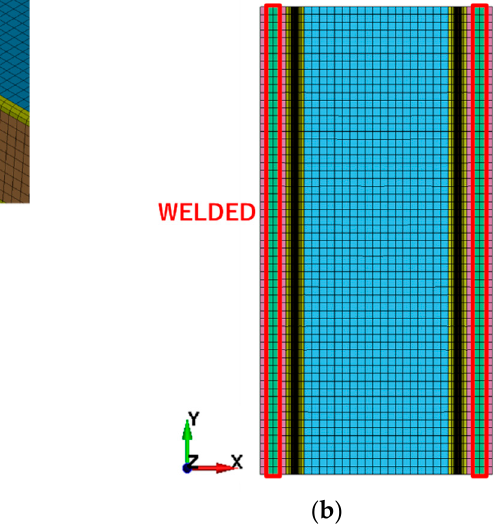
Figure 5. FEA model of the crash box: ( a ) Isometric view; ( b ) front view.